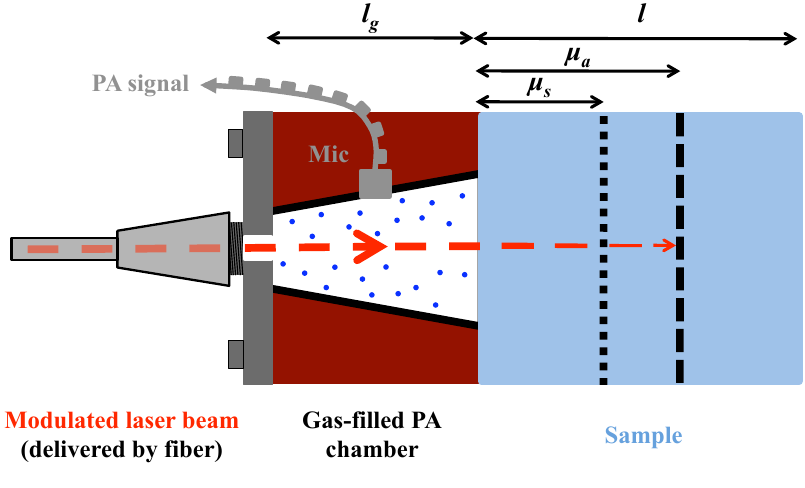
Figure 1. Illustration of the PA signal generation. According to the Rosencwaig–Gersho model [23] the length ratios between the sample length l , the optical absorption length µ = 1 /α and the thermal diffusion length µ are used to distinguish different cases. In a s > µ this figure a length ratio of l > µ is pictured, as in the samples studied in this work. a s The periodical PA signal is detected with a microphone (Mic) in the gas-filled PA chamber of length l g